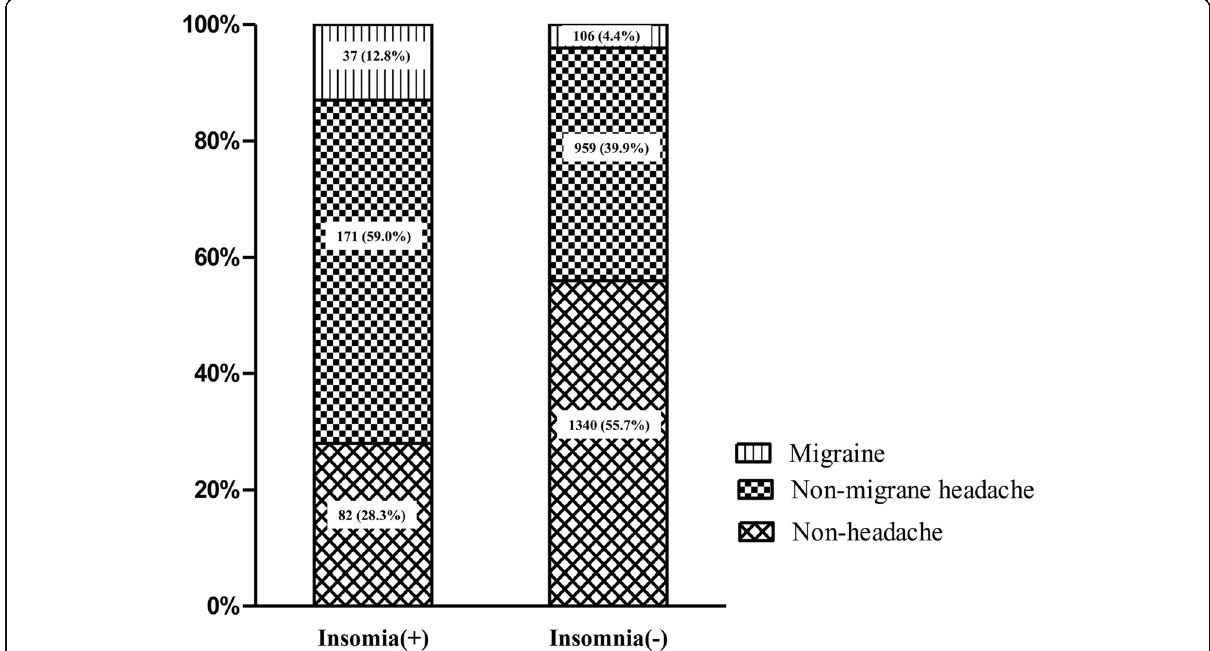
Fig. 2 Comparison of headache type according to the presence of